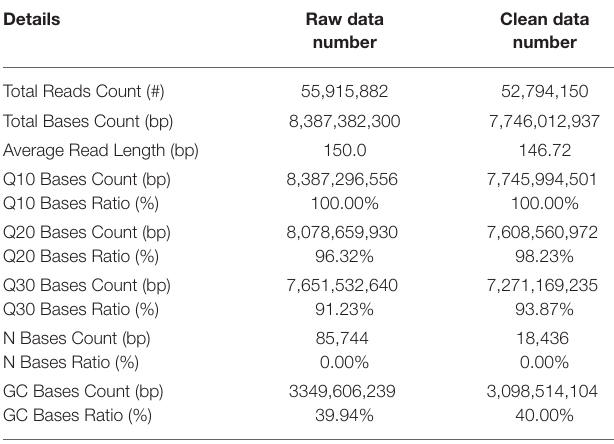
TABLE 1 | Summary of the M. aurolineatus